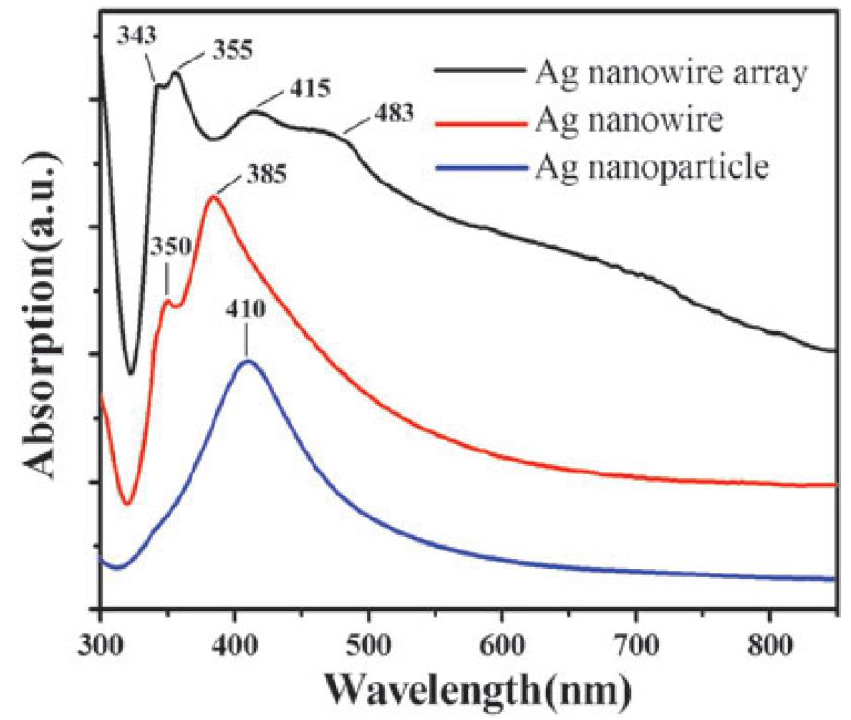
Figure 7. Ultraviolet-visible (UV-vis) absorption of different silver nanostructures